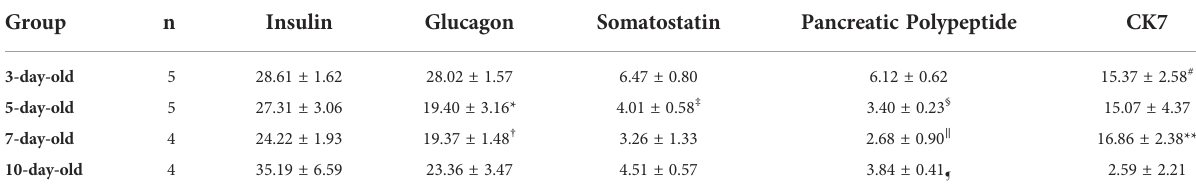
TABLE 1 Cell composition of islets from various ages of neonatal pigs. Mean Percentage of Stained Positive Cells ± SEM